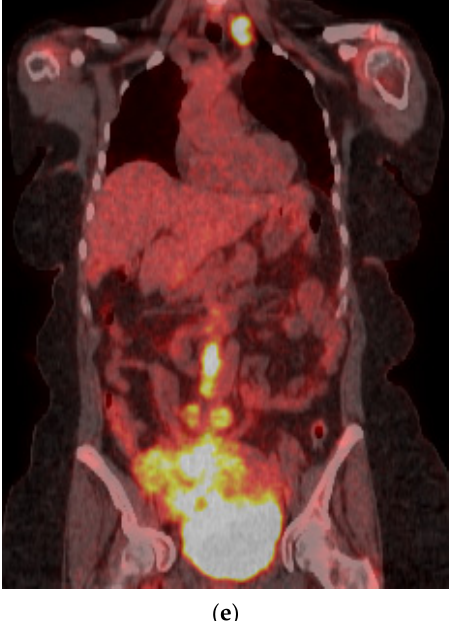
Figure 7. Marked progression of locally advanced bladder cancer and metastatic disease. ( a ) Axial CT image demonstrates a small lesion in the anterior bladder which went untreated for 16 months. ( b ) Follow up axial CT image showing significant progression of the mass which now extends beyond the bladder to involve the uterus, right adnexa, and right pelvic side wall. ( c ) Axial PET/CT image redemonstrating the locally advanced mass with bilateral pelvic lymphadenopathy. ( d ) Axial PET/CT image shows metastatic retroperitoneal lymphadenopathy. ( e ) Coronal PET/CT image also showing metastatic left supraclavicular lymphadenopathy. Biopsy of the left supraclavicular node showed poorly differentiated carcinoma compatible with bladder primary.